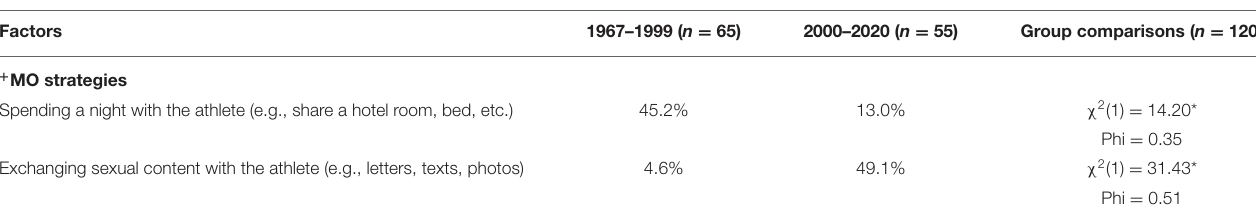
TABLE 5 | Comparison of MO strategies used based on year of first offending. Factors + MO